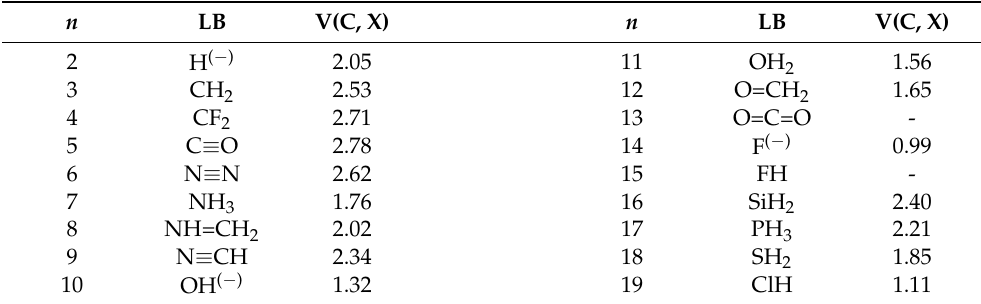
Table 3. Population of ELF disynaptic basins V(C, X) in tetrel complexes ( 1 : n ), n = 2 – 19 , describing the C · · · X interaction. LB = Lewis